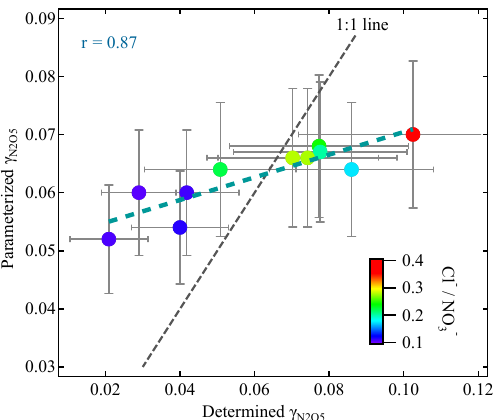
Figure 8. Comparison of field-determined γ with that derived from the parameterization of Bertram and Thornton (2009). The colors of the markers indicate the corresponding concentration ratio of partic- ulate chloride to nitrate. The error bars represent the total aggregate uncertainty associated with measurement and